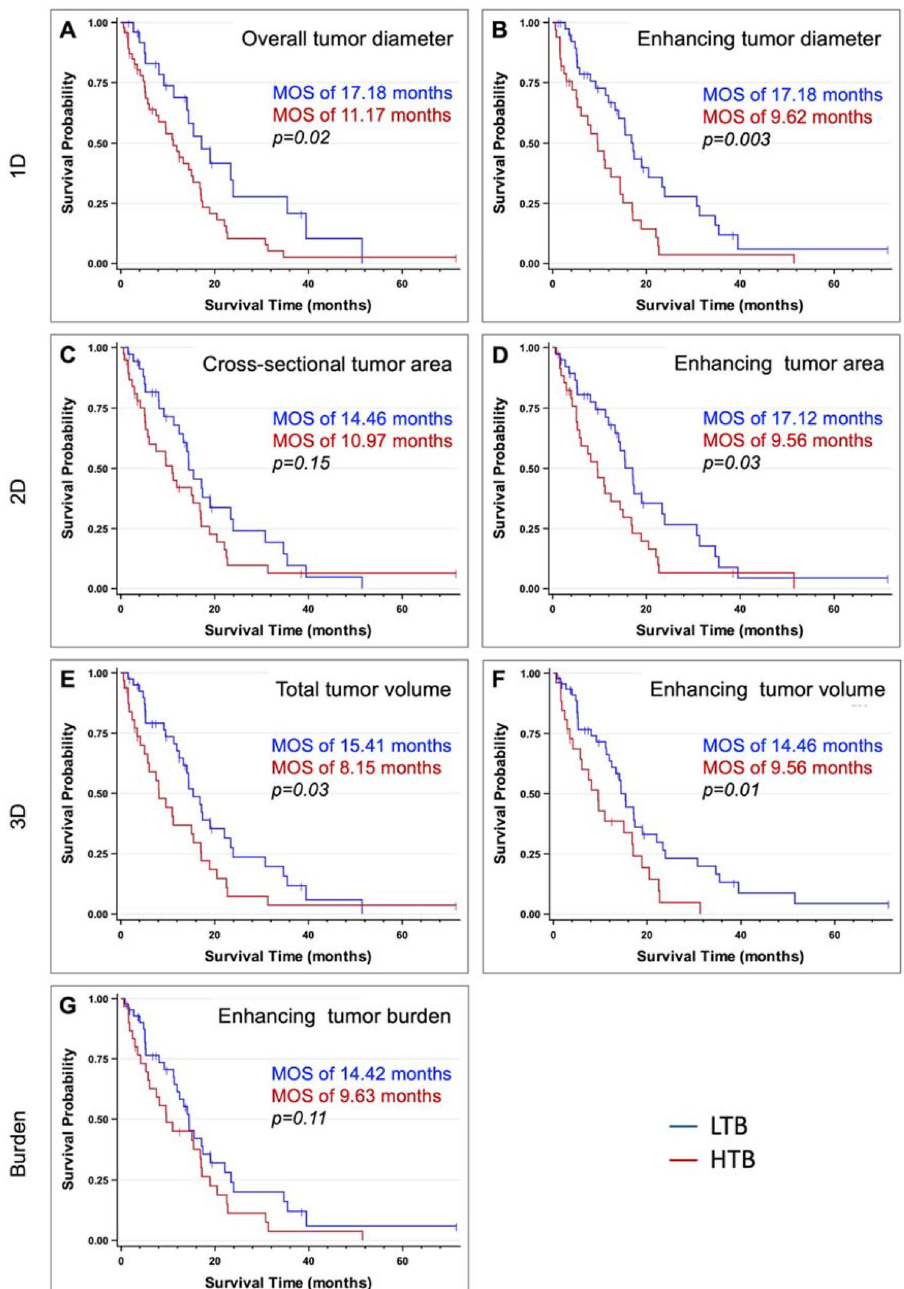
Figure 3. Kaplan–Meier analysis for overall survival calculated for each tumor burden assessment method after categorizing the ICC patients into two groups of low tumor burden (LTB) and high tumor burden (HTB). ( A,B ) Show the 1D-based tumor assessment methods, the largest overall tumor diameter and largest enhancing tumor diameter. ( A ) ICC patients with largest overall tumor diameter of ≤ 9.3 cm were categorized into the LTB group. There was a significant difference between survival curves of the LTB and HTB groups based on the Log-rank test ( p = 0.02). ( B ) Patients with the largest enhancing tumor diameter of ≤ 8.5 cm were enrolled into the LTB group. A significant separation of survival curves between the LTB and HTB groups is shown with p = 0.003. ( C,D ) compare the LTB and HTB groups’ survival curves when using the 2D tumor assessment methods, maximum cross-sectional tumor area, and maximum enhancing tumor area. ( C ) The LTB group includes patients with a tumor burden of ≤ 50.0 cm 2 for maximum cross-sectional area. The log-rank test showed no significant separation between survival curves of the LTB and HTB groups ( p = 0.15). ( D ) For maximum enhancing tumor area, categorization into the LTB group was conducted when the maximum enhancing tumor area was ≤ 25.0 cm 2 . The log-rank test demonstrates a p = 0.03 between survival curves for the LTB and HTB groups. ( E , F,G ) Present Kaplan–Meier curves when using 3D quantitative tumor analysis. ( E ) Categorizing LTB according to assessment of total tumor volume was done when tumor burden was ≤ 410 cm 3 . Log-rank test showed a p = 0.03 between Kaplan–Meier curves of LTB and HTB. ( F ) The LTB group was composed of ICC patients with enhancing tumor volume of ≤ 275 cm 3 ( p = 0.01 between survival curves of the LTB and HTB groups). ( G ) When using enhancing tumor burden, patients were stratified to LTB when enhancing tumor burden was ≤ 10.0%. A p = 0.11 was achieved in the log-rank test between survival curves of the LTB and HTB groups. MOS: Median overall